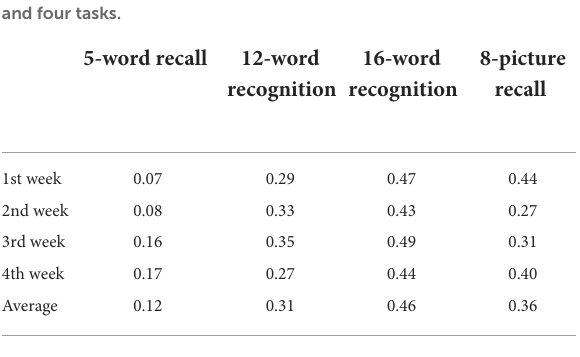
TABLE 3 R -value and p -value of the correlation between WMS-R LM II score and each new methods of this